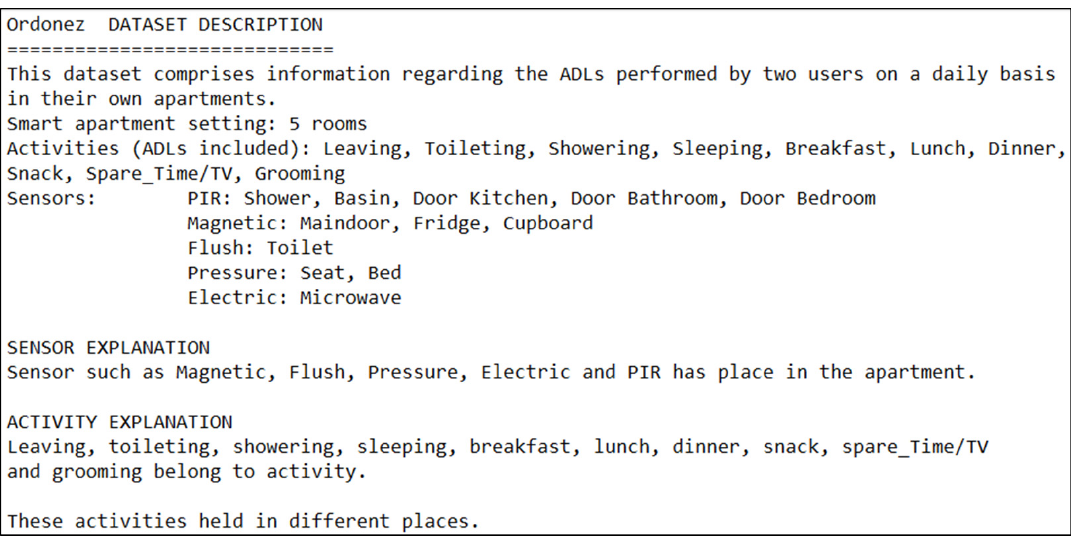
Figure 7. Candidate data source selection at t 1 , the Ordonez dataset.